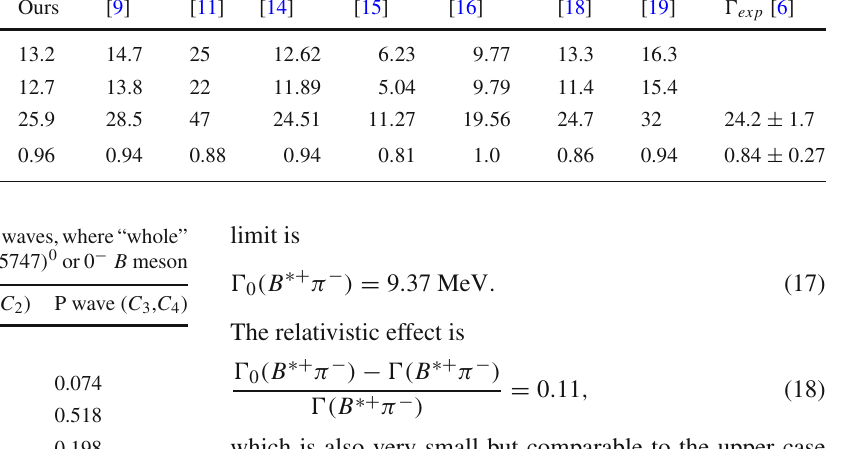
Table 1 Decay width of B ∗ (5747) 0 , in units of MeV 2